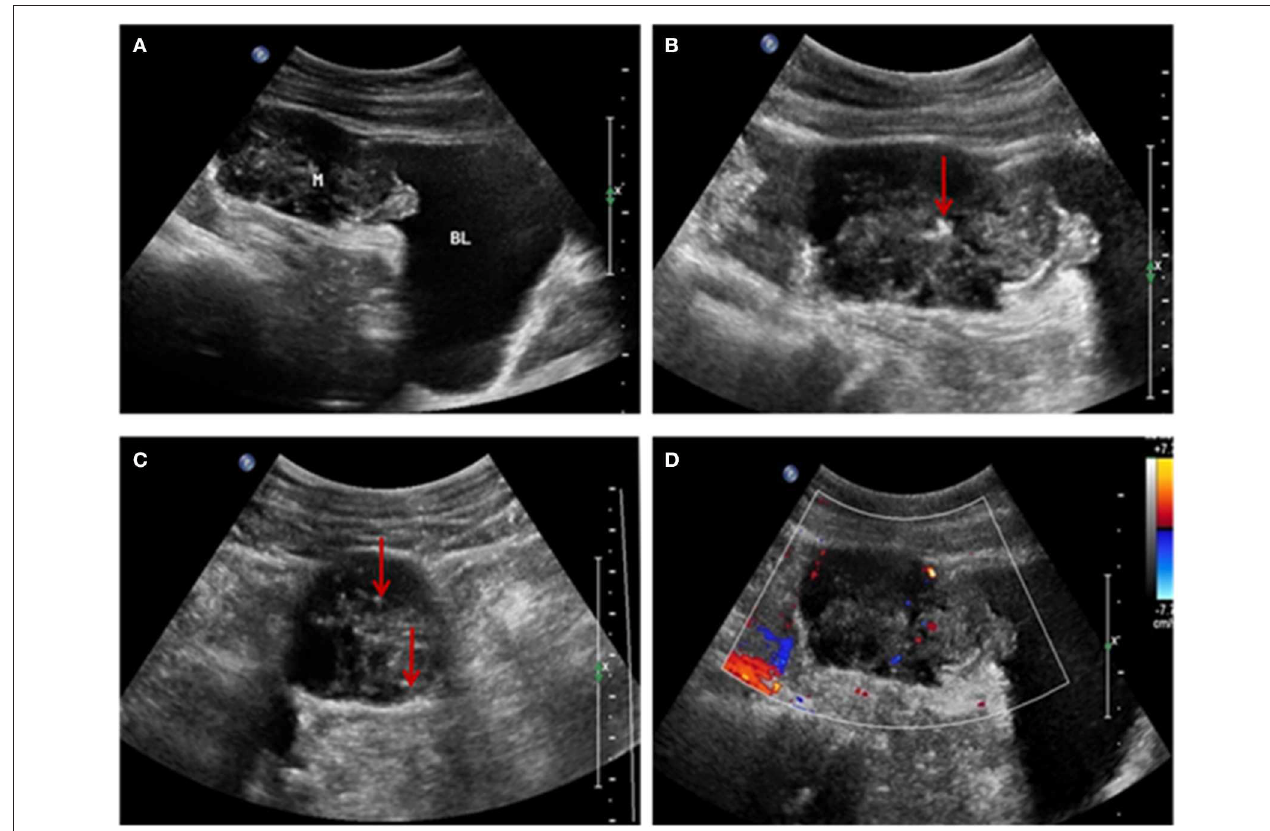
FIGURE 1 | (A) Ultrasonographic image showing a solid mass above the bladder invading the bladder wall and with an irregular shape and uneven internal echogenicity. (B,C) Patchy calcification within the mass (red arrow). (D) Color-flow Doppler image showing patchy and short-line blood flow signals within the